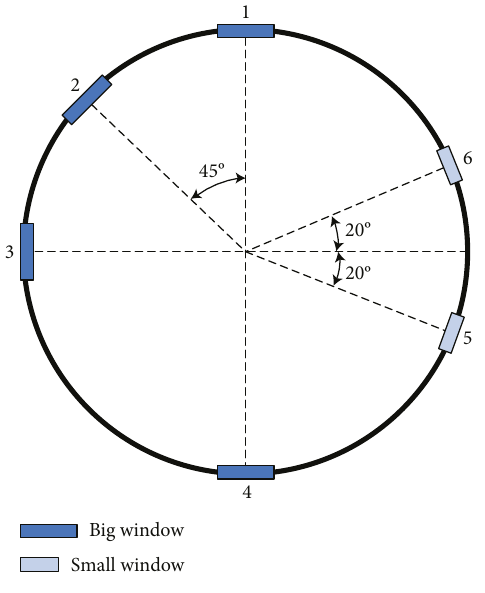
Figure 2: Location of